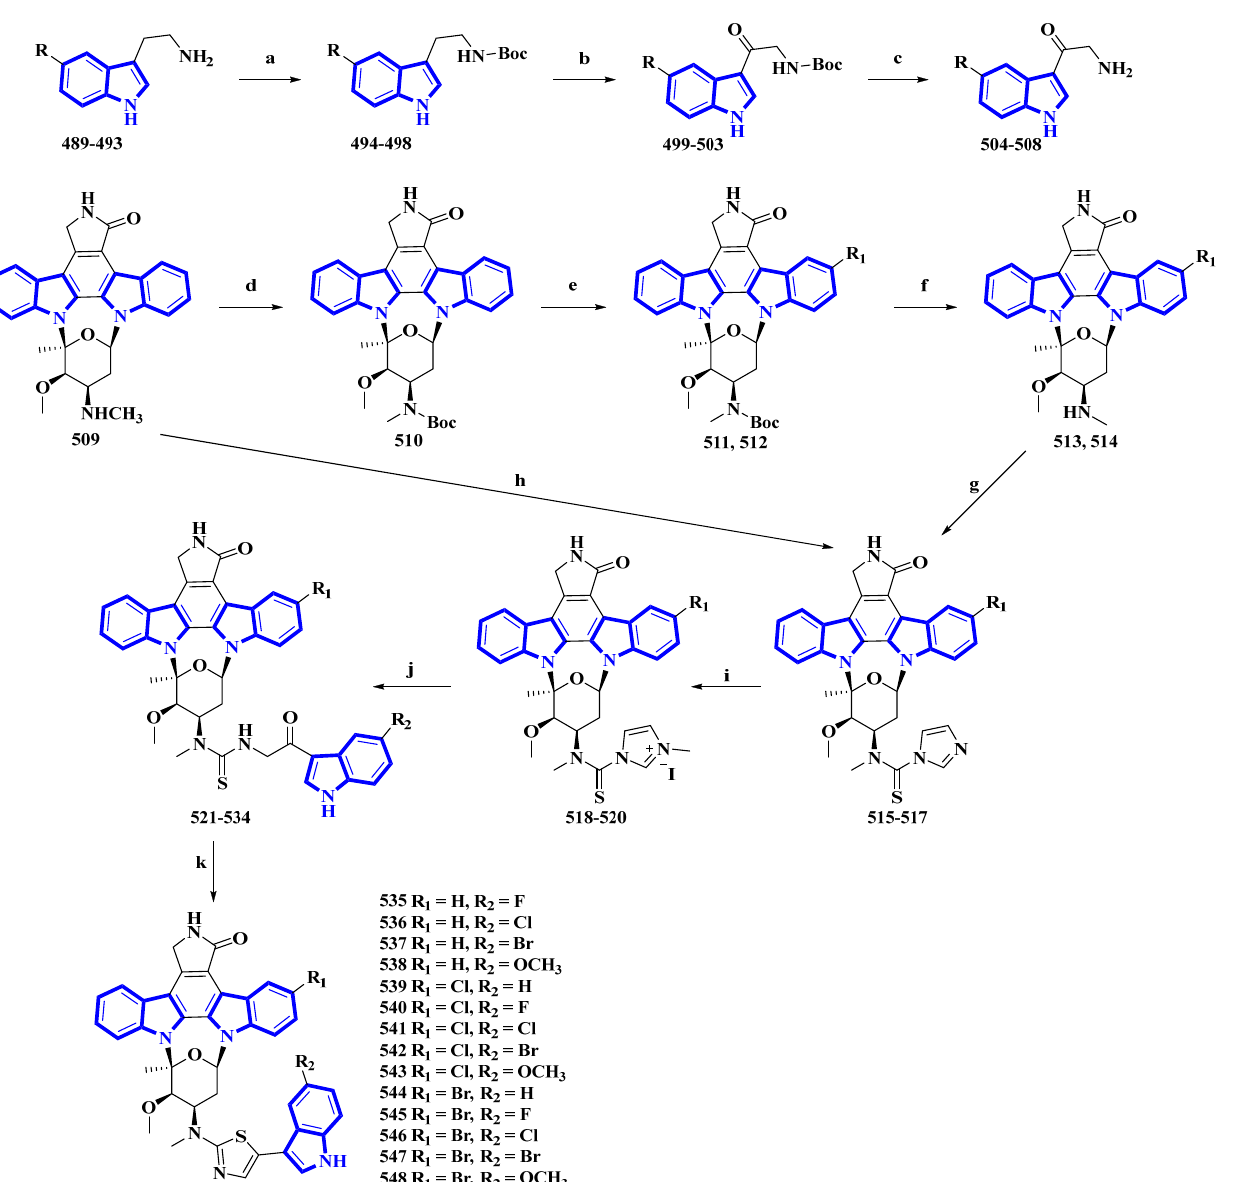
Figure 25. Synthesis of fradcarbazole A derivatives 535 to 548 . (a) Boc 2 O, Et 3 N, THF, 10 ◦ C,